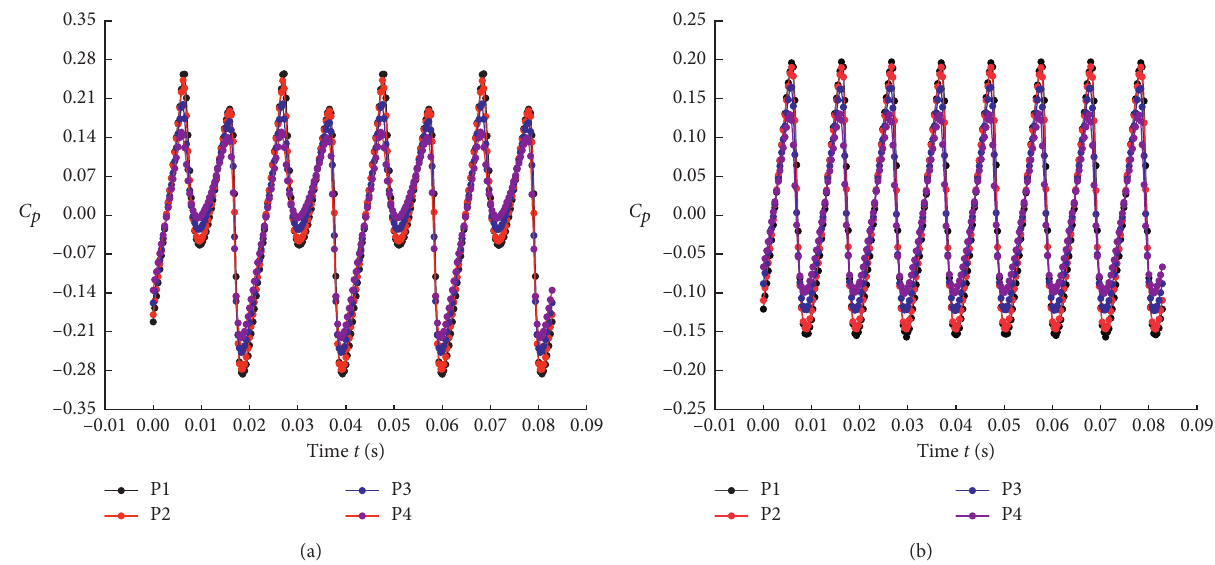
Figure 16: Time domain of each monitoring point at the impeller inlet ( Q � Q